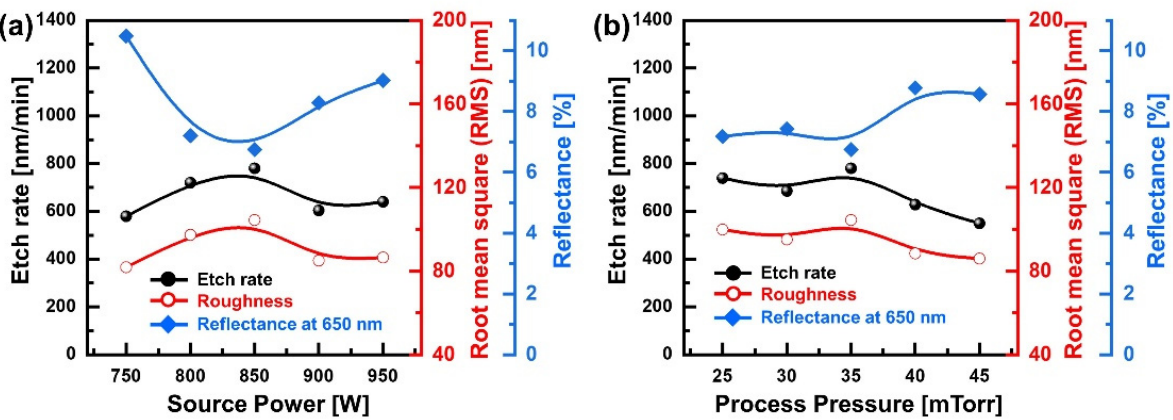
Figure 5. Etch rate, surface roughness, and reflectance following the process conditions: ( a ) source RF power and ( b ) process pressure.